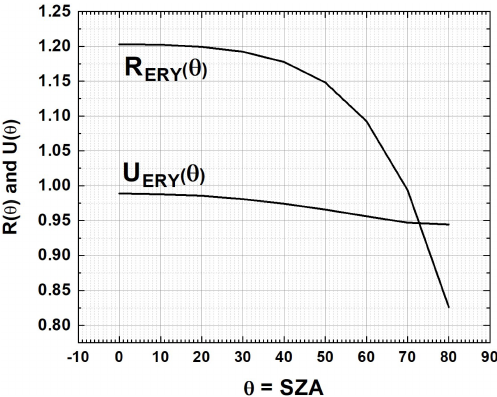
Figure A1. Values of the coefficients R ERY (θ) and U ERY (θ) .